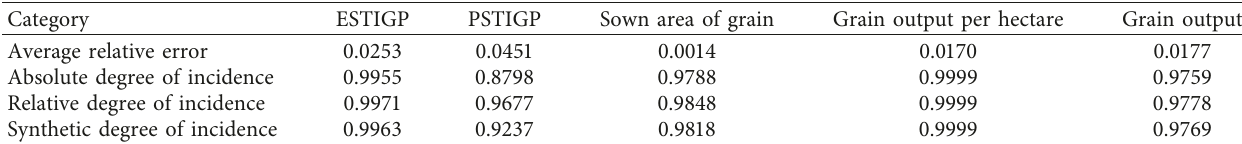
Table 4: System accuracy calculation